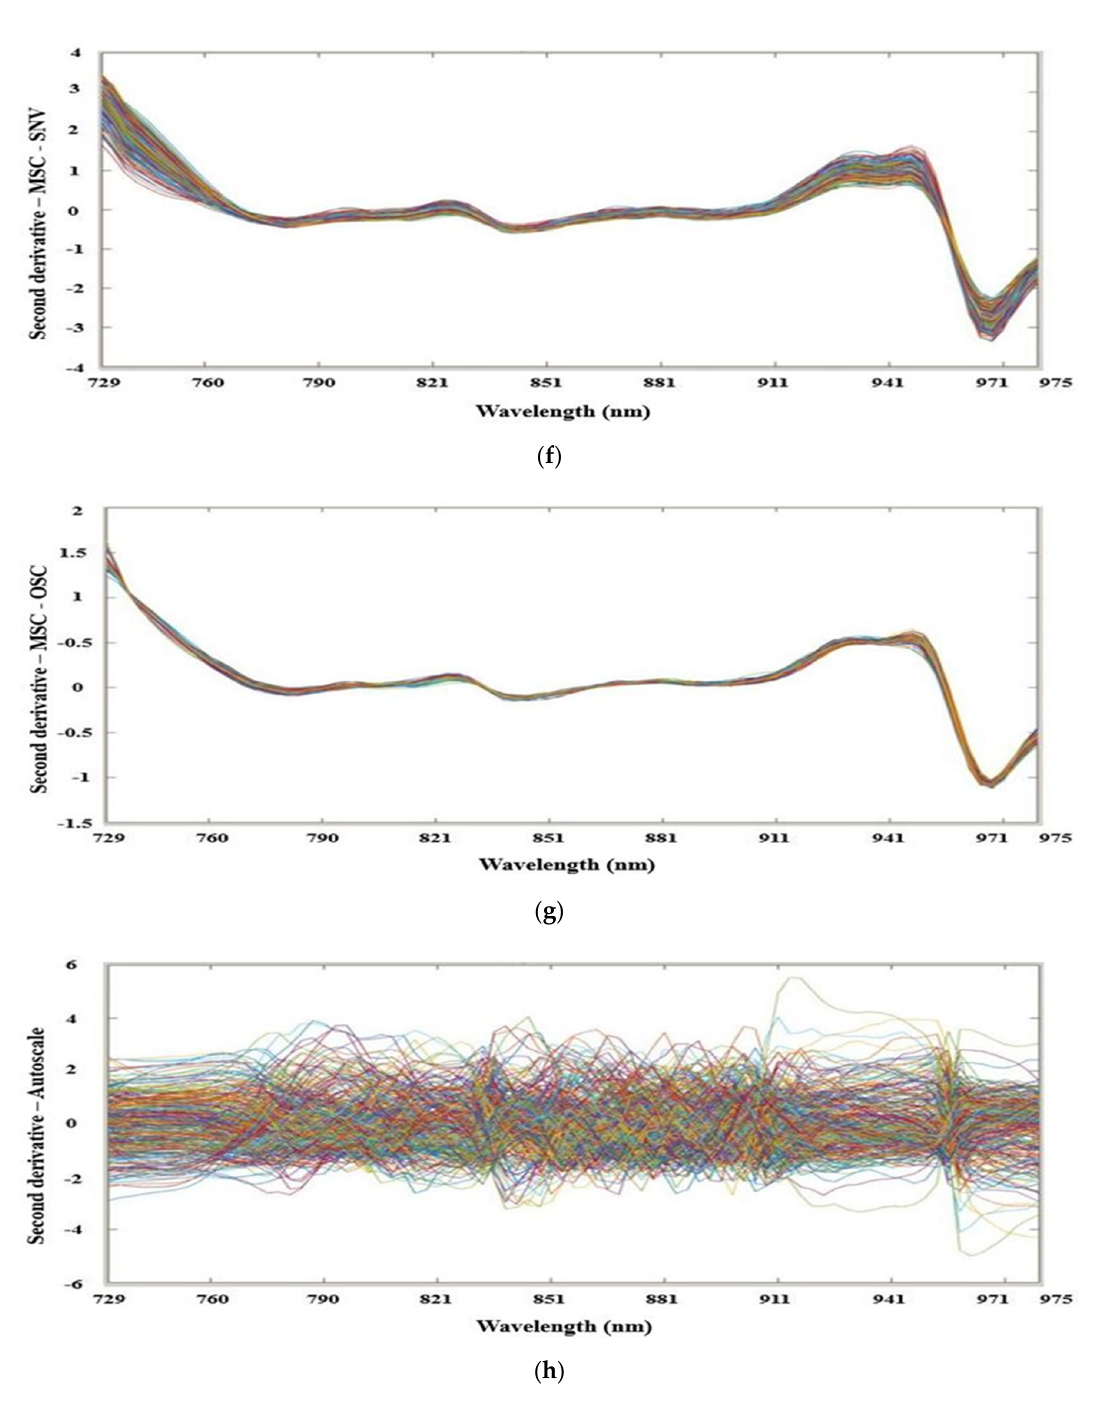
Figure 1. ( a ) Second derivative (SD) spectra; ( b ) spectra by SD + MSC; ( c ) spectra by SD + SNV; ( d ) spectra by SD + OSC; ( e ) spectra by the combination of SD, standard normal variate (SNV), and orthogonal signal correction (OSC); ( f ) spectra by the combination of SD, multiplicative signal correction (MSC), and SNV; ( g ) spectra by the combination of SD, MSC, and OSC; and ( h ) spectra by the combination of SD and Autoscale, from hardy kiwi samples.